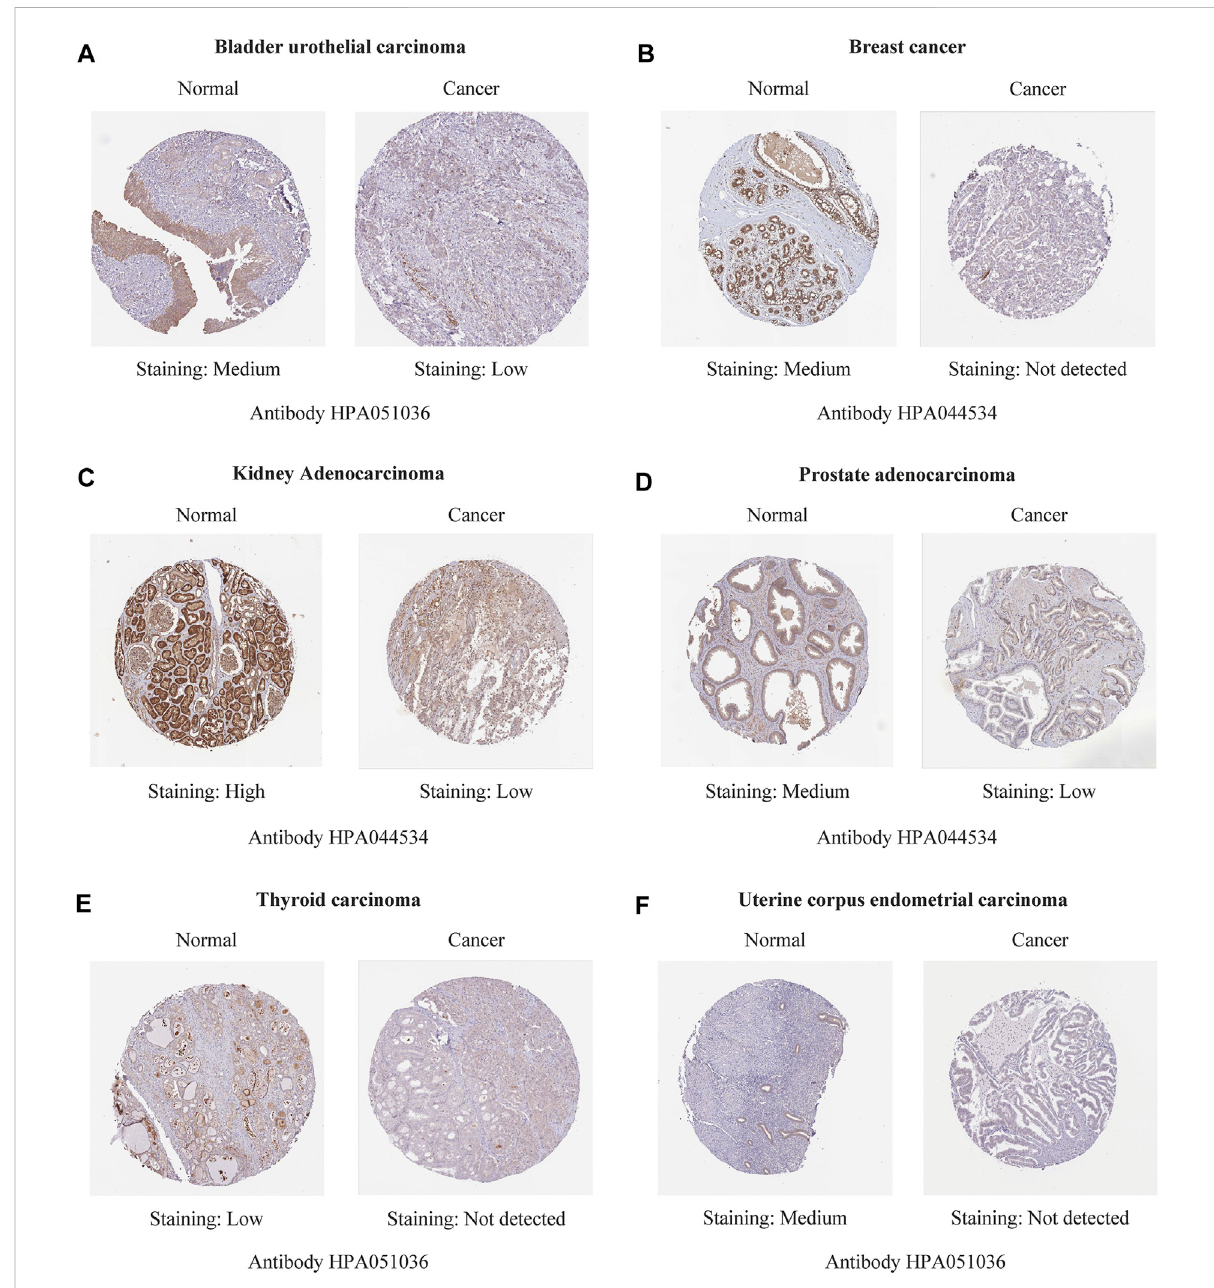
FIGURE 7 Theimmunohistochemistry stainingimages ofREV1indifferenttypesoftumortissues andnormal tissues[urinary bladder (A) ,breast (B) ,kidney (C) , prostate (D) , thyroid (E) , and endometrium (F)